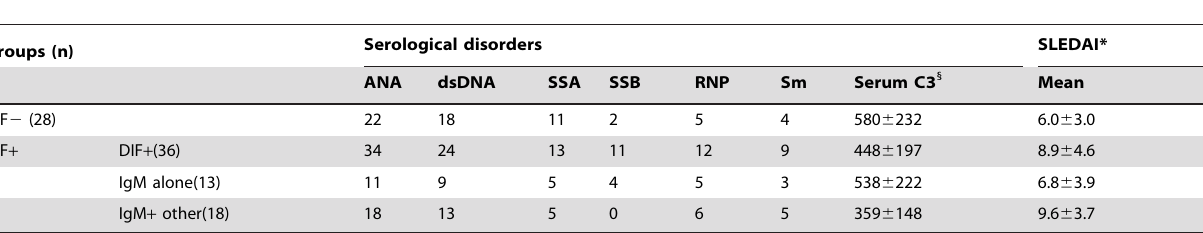
Table 2. Association of cutaneous IgM with serological disorders and SLEDAI.